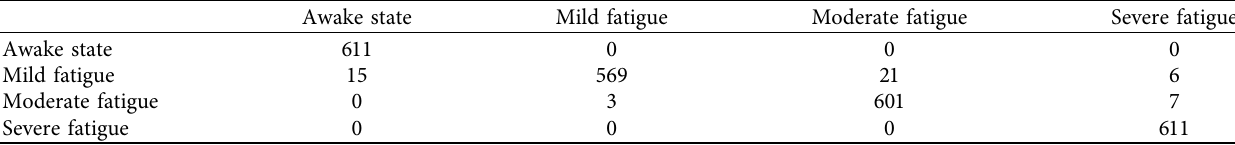
Table 6: Confusion matrix of classification results of LSTM model on the test set.